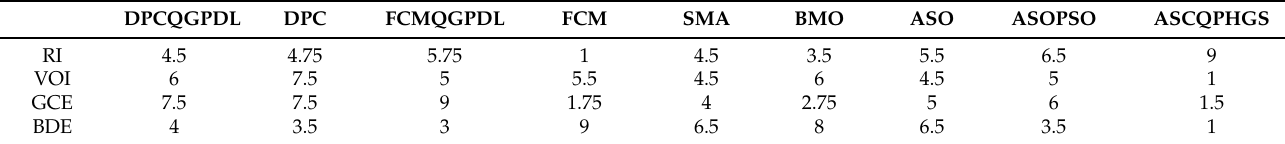
Table 3. Friedman test results of the developed ASCQPHGS and other methods using SBD and BSD500 datasets.